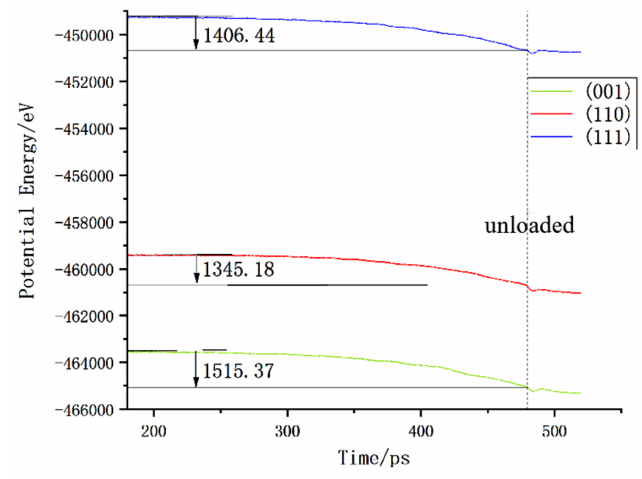
Figure 29. Potential energy changes of different loading surfaces.